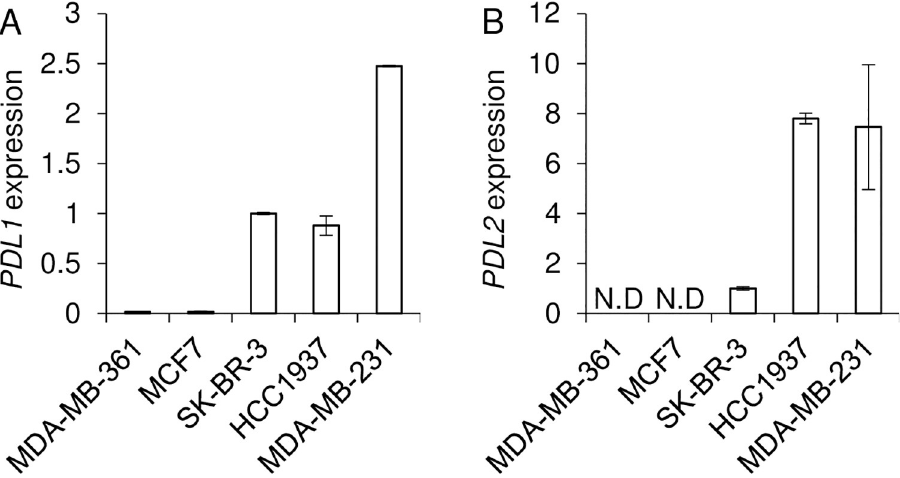
Fig 1. The mRNA expression of PD-L1 and PD-L2 in breast cancer cell lines. The relative mRNA expressions of PD-L1 (A) and PD-L2 (B) on breast cancer cell lines were measured by qPCR (n = 4 each). The values were relative to the mRNA expressions of SK-BR-3. Each mean ± SEM is shown. N.D: Not detected.